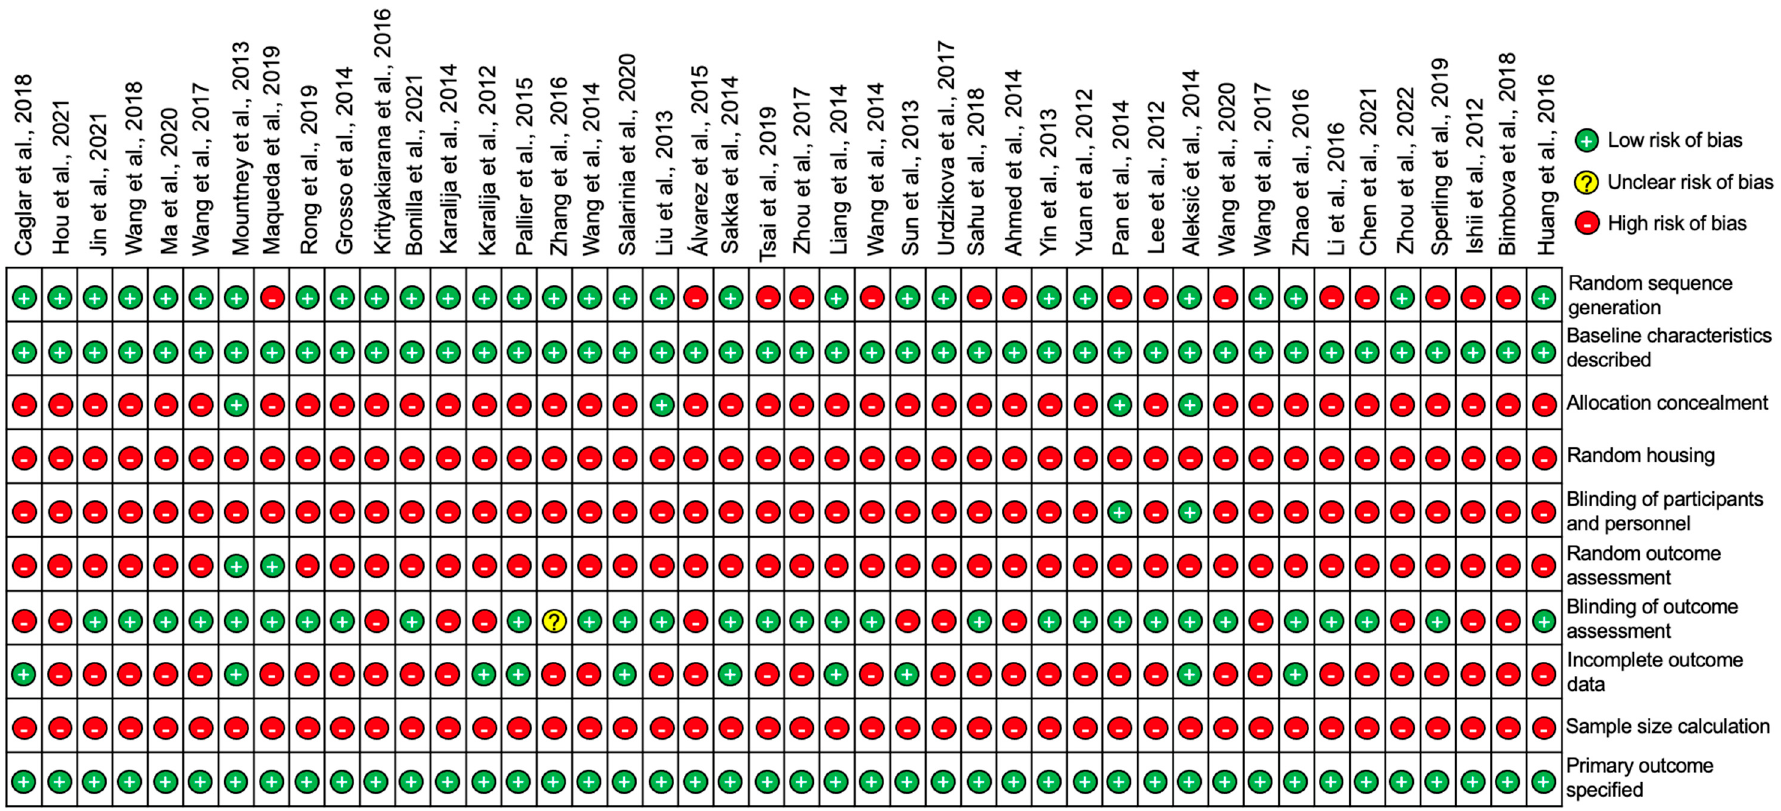
Figure 9. Diagram to represent the risk of bias in individual studies for all 44 studies included in this review [11–54].